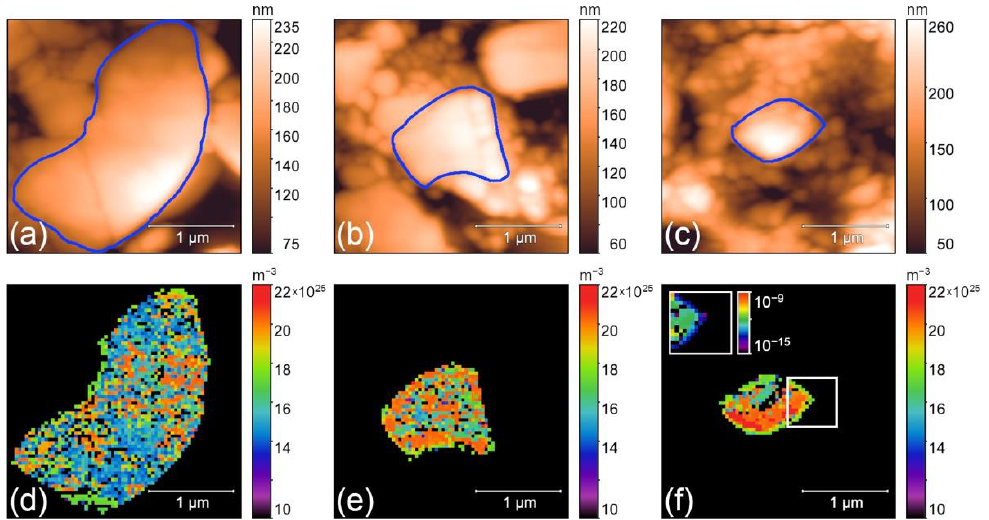
Figure 4. ( a – c ) Topography and ( d – f ) lithium ion concentration in the fresh Li 0.6 Mn 2 O 4 . At ( f ) inset: variation in diffusion coefficient near the particle border.